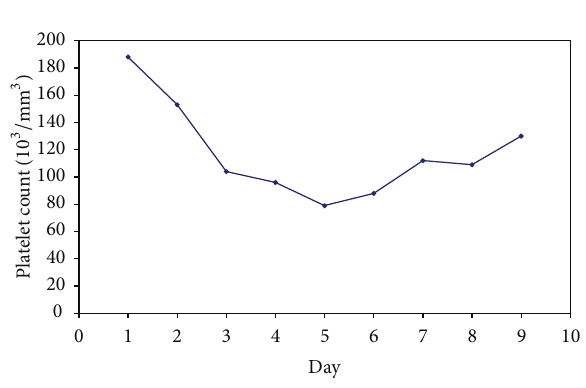
Figure 1: Patient phosphorous level.